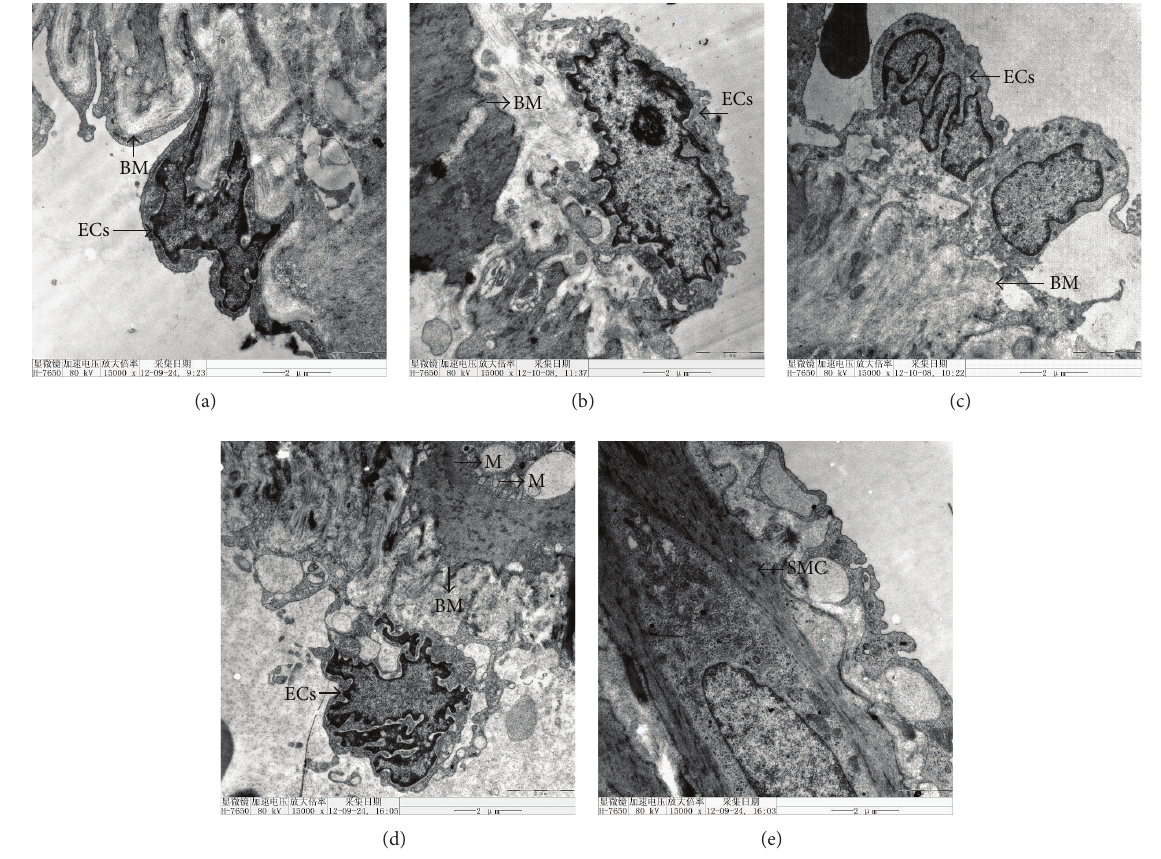
Figure 7: Ultrastructural changes of the portal vein after CC14 injections. (a) Control group, (b) week 4, (c) week 6, (d) week 8, and (e) week 10 after CCl4 injection. ECs, endothelial cells; SMC, smooth muscle cell; M, mitochondrion; BM, basement membrane. Magnification